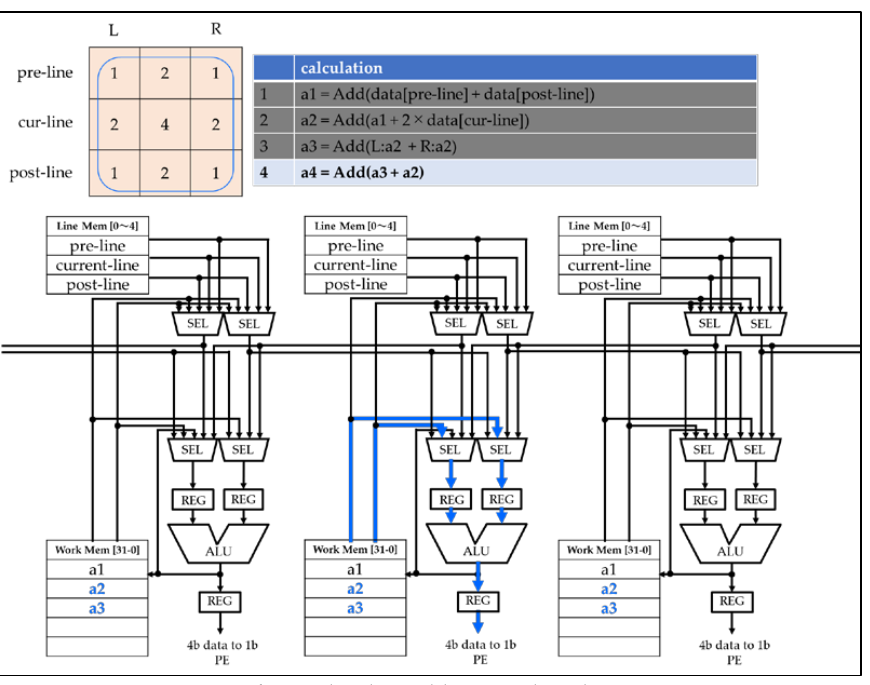
Figure 15. The eight-neighbor Gaussian filter data flow. This is the data flow of ALU step by step. The ALU calculates from ( a – d ). Upper-left image is filter tap and coefficient. The filter is using red pixels.